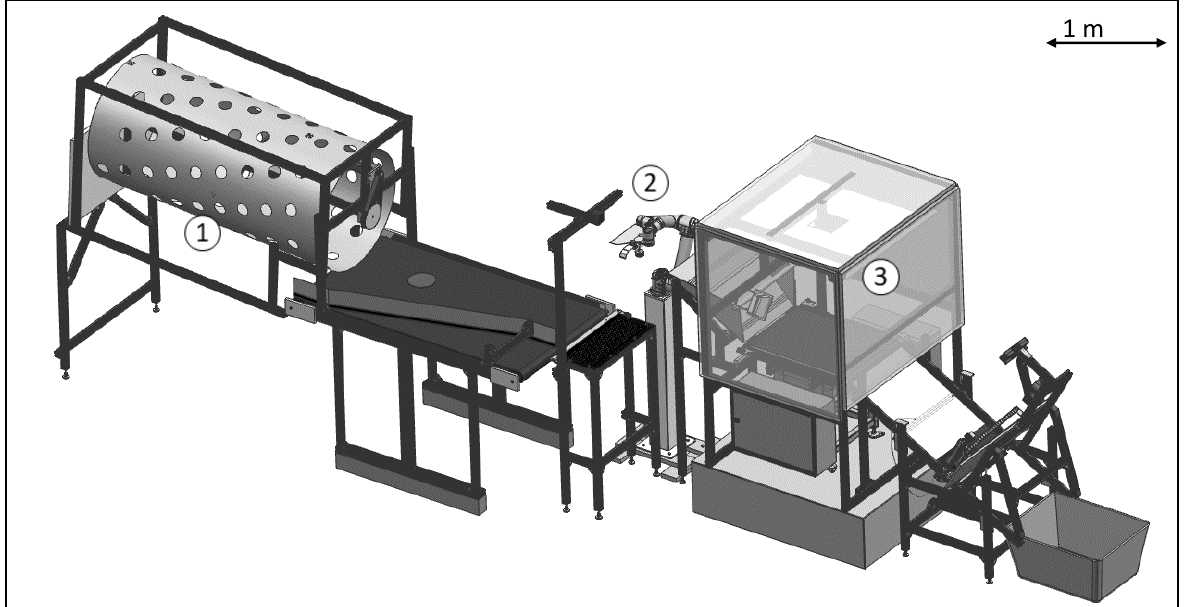
Figure 1. CAD representation of the automatic measuring